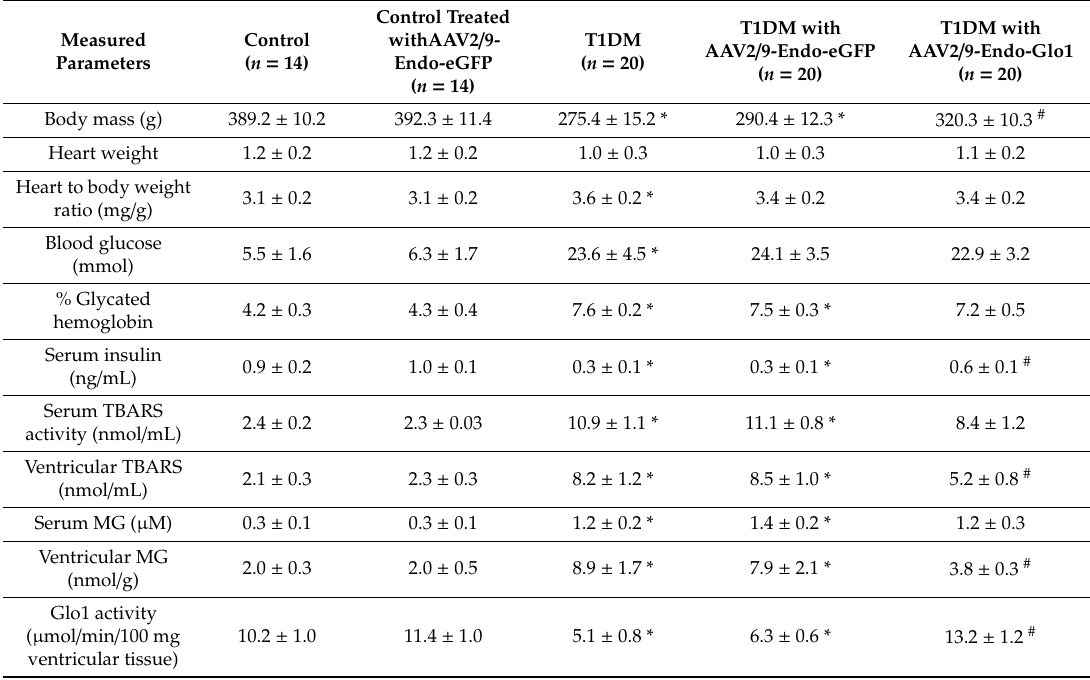
Table 1. General characteristics of animals used in the